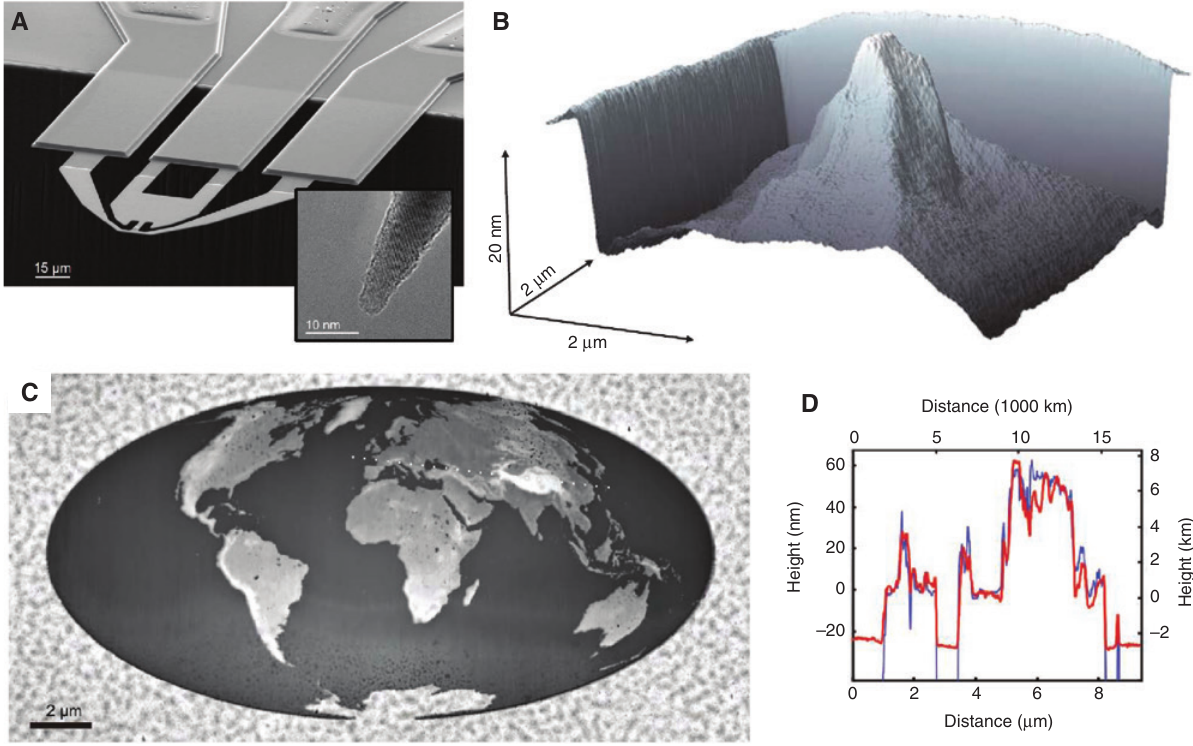
Figure 14: Thermal scanning probe lithography (t-SPL): (A) tip used for 3D t-SPL patterning; close up TEM image in the inset; (B) AFM image of the mountain Matterhorn replica patterned into a molecular glass [9]; (C) AFM topography image of a 3D world map patterned into a 250 nm thick PPA layer [10]; (D) profile cross-section of the dotted line shown in (C), blue and red lines represent original data and the relief reproduction,